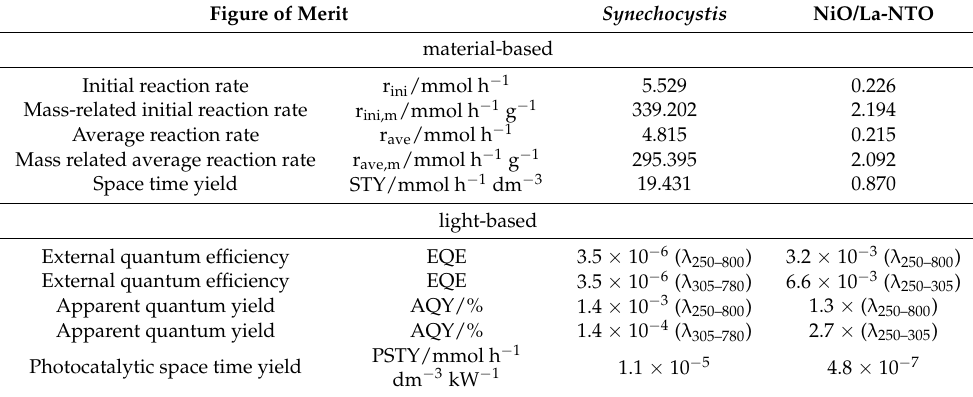
Table 2. Material-based and light-based figures of merit for Synechocystis and NiO/La-NTO at maxi- mum product evolution rate in this study ( Synechocystis : c cell = 0.163 g dm − 3 , I light = 50 mW cm − 2